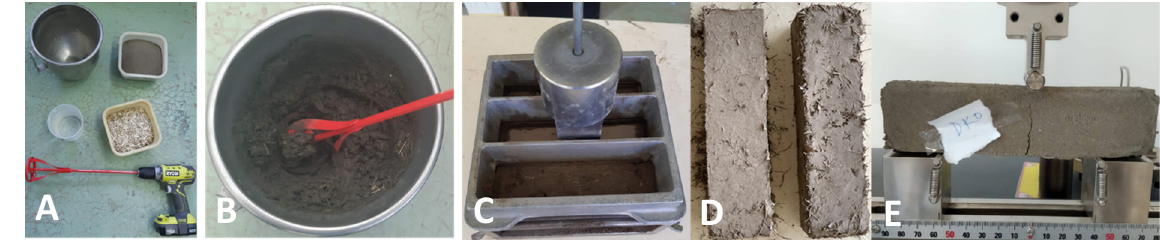
Figure 4. Raw materials ( A ), mixing ( B ), compaction ( C ), drying ( D ), and bricks testing ( E ). Dunkirk sediments were dried in the oven for 24 h to remove water and humidity.